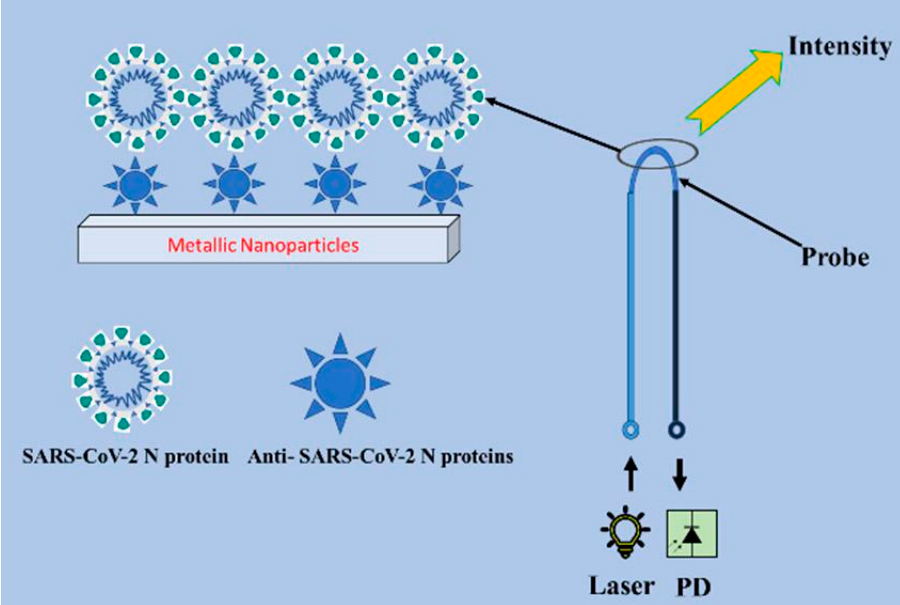
Figure 20. Immunosensor based on optical fiber for SARS-CoV-2 detection in oropharyngeal or nasopharyngeal swabs. Two-layer AuNPs structures can be immobilized onto the surface of a U- shaped plastic optical fiber and used to immobilize anti-nucleoprotein antibodies. The detection of viral particles triggers changes in the refracted light within the fiber that are enhanced by the plasmonic behavior of AuNPs. Image adapted from [125] with permission of Multidisciplinary Digital Publishing Institute, 2022.